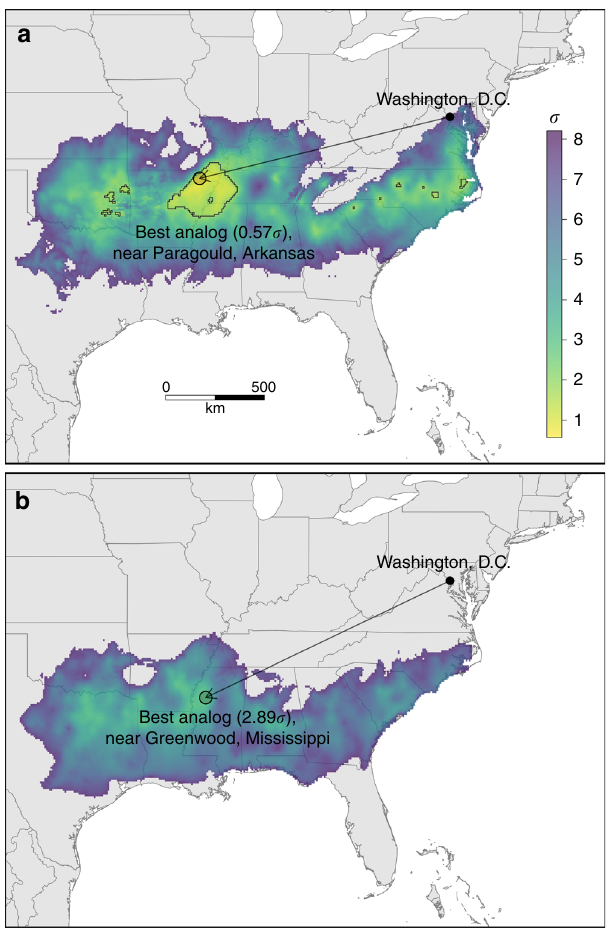
Fig. 1 Climate analog maps for 2080 ’ s Washington DC. Shading indicates sigma dissimilarity for the ensemble mean of the 27 climate projections for a RCP4.5 and b RCP8.5. The arrow and circle highlight the location of the best contemporary climatic analog where sigma dissimilarity is minimized. Outlined pixels indicate locations with sigma dissimilarity <2 (present for RCP4.5 only)